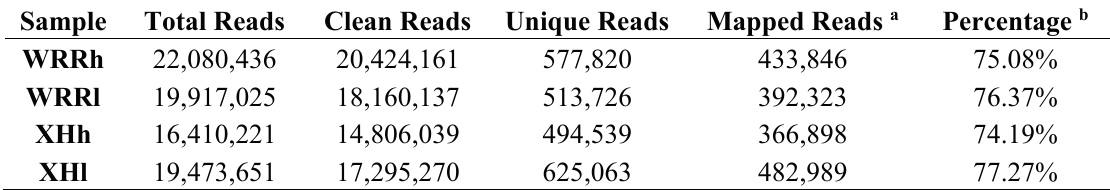
Table 1. Summary of data generated from small RNA deep sequencing.